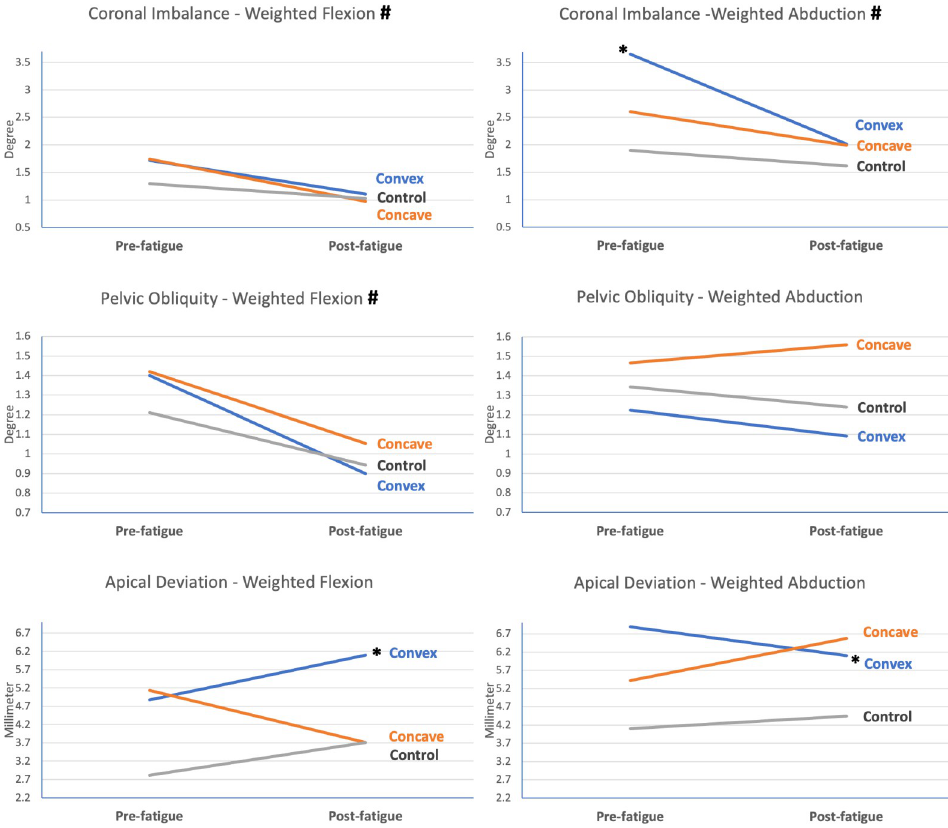
Fig 8. Coronal-plane spinal kinematics during weighted flexion and weighted abduction tasks of the shoulder joint. # represents significant time effect between pre- and post- fatigue measurement (p < 0.05); � represents significant time- and-group interaction between the indicated side and control group (p <